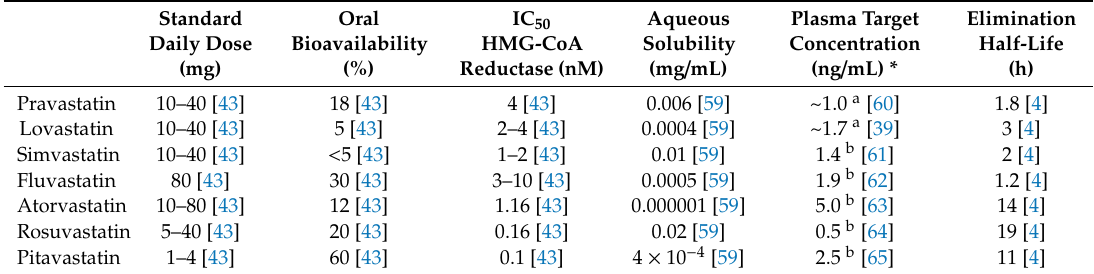
Table 1. Relevant pharmacokinetic, pharmacodynamic and physiochemical properties of